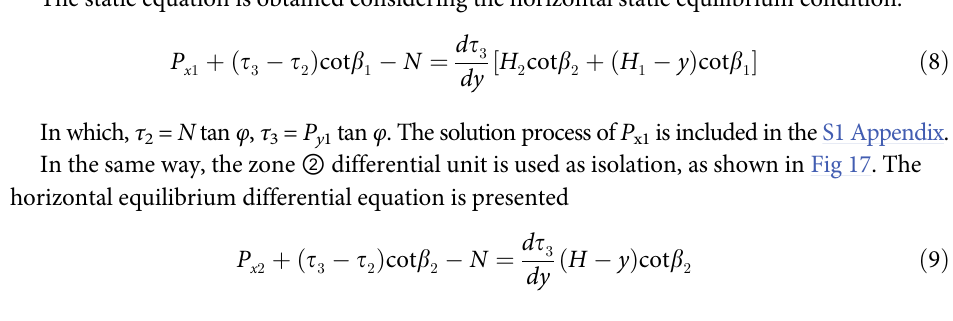
The solution process of P